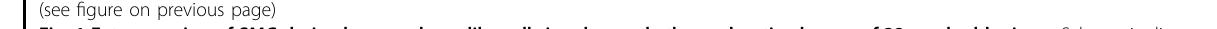
Fig. 1 Fate mapping of SMC-derived macrophage-like cells in advanced atherosclerotic plaques of 32-week-old mice. a Schematic diagram showing the dual recombinase-mediated sequential intersectional genetic strategy. Step 1: Dre-rox recombination switches CD11b-CrexER to the CD11b-Cre genotype in smMHC + cells; Step 2: when CD11b is activated, Cre-loxP recombination genetically labels CD11b-expressing cells. b Flow cytometric analysis of tdTomato + cells in the blood, spleen, and bone marrow of Myh11-Dre;CD11b-CrexER;R26-tdT;LDLR − / − mice. c Schematic diagram showing the experimental strategy. Mice were treated with a high-fat diet (HFD) or normal laboratory diet. d Immunostaining for tdT and aSMA on aortic sections from 16-week-old mice treated with HFD or normal diet. e Whole-mount images of aortas after Sudan IV staining. f Immunostaining for tdTomato (tdT) and aSMA in aortic sections from mice treated with HFD or normal diet. g Immunostaining for tdT and CD45, CD11b, F4/80, LGALS3, or CD68 on plaque sections. Arrowheads, tdT + macrophages. h Quanti fi cation of % of tdT + cells expressing different macrophage markers in the plaques. Data are expressed as means ± SEM; n = 5. i Immunostaining for tdT and SMC markers. Arrowheads, tdT + SMCs. j Quanti fi cation of the % of tdT + cells expressing different SMC markers in the plaques. Data are expressed as means ± SEM; n = 5. k Immunostaining for tdT and fi broblast or pericyte markers. Arrowheads, tdT + fi broblasts or pericytes. l Quanti fi cation of the % of tdT + cells expressing fi broblast or pericyte markers in the plaques. Data are expressed as means ± SEM; n = 5. m Quanti fi cation of the % of fi broblasts or pericytes expressing tdT in the plaques. Data are expressed as means ± SEM; n = 5. n Flow cytometric analysis of different lineage markers expressed by tdT + cells isolated from the plaques. o tSNE analysis of scRNA-seq data of 10,618 plaque cells from Myh11-Dre;CD11b-CrexER;R26-tdT;LDLR − / − mice fed with 24 weeks HFD. p Feature plot of tdTomato in different clusters. 1946 tdT + cells are presented in the clusters. q Cartoon image showing a subset of SMC-derived macrophage-like cells adopting a transient cell fate and contributing to SMCs, pericyte-like cells, and fi broblast-like cells in the fi brous cap and atherosclerotic plaques. Scale bars: black, 1 mm; white, 100 µm. Each image is a representative of fi ve individual biological